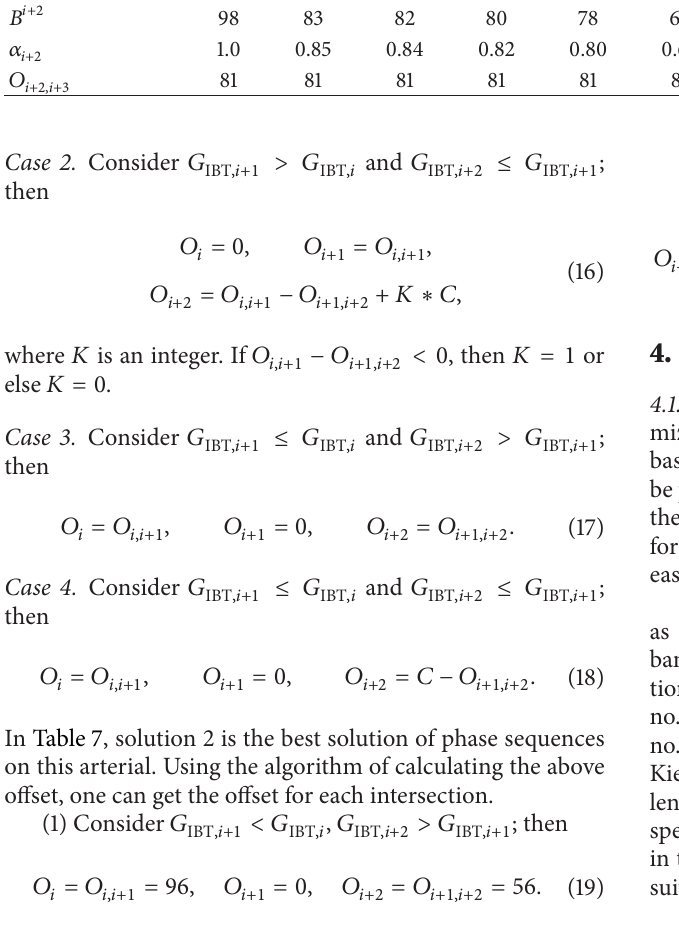
Table 4: Optimized results for 𝐿 𝑖,𝑖+1 on Kietzke Lane ( 𝐺